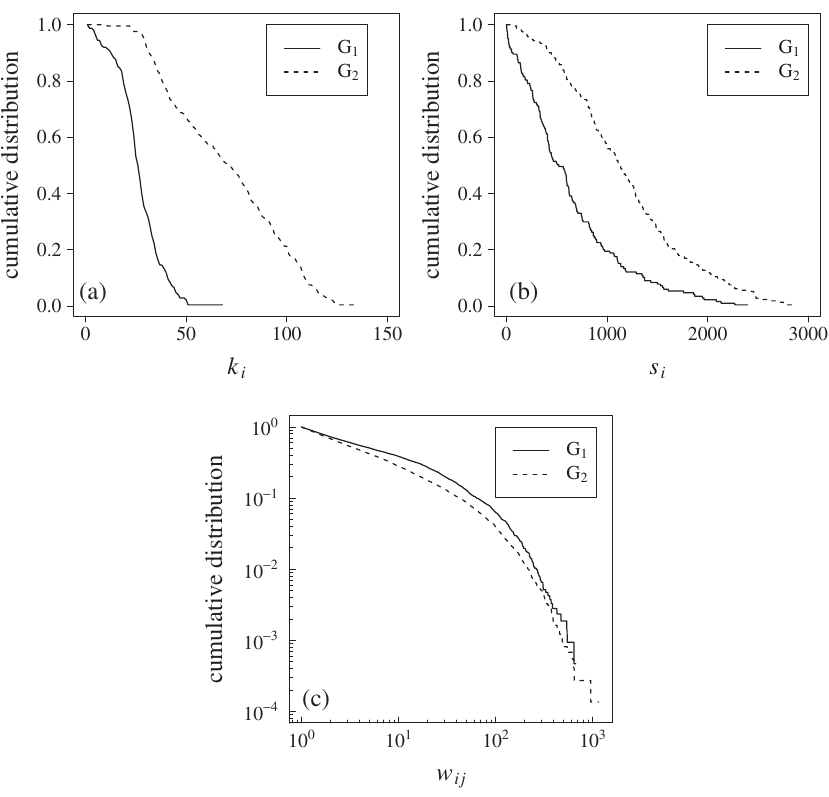
FIG. 3. Cumulative distributions of (a) degree, (b) node strength, and (c) link weight of the